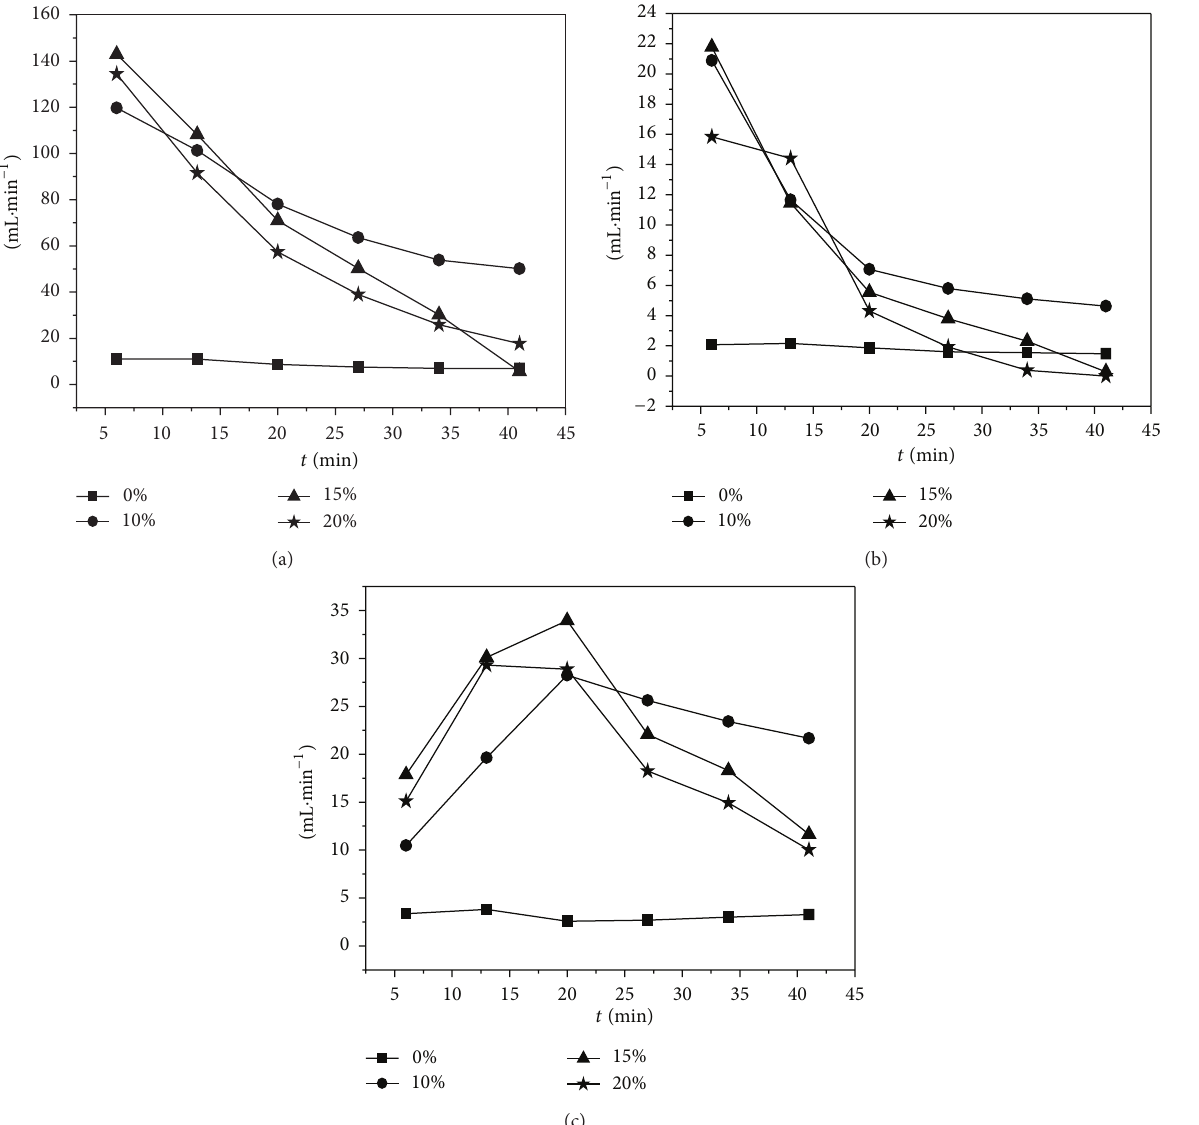
Figure 3: The generation rate versus time in experiments with different catalyst contents. (a) Hydrogen, (b) carbon monoxide, and (c) carbon